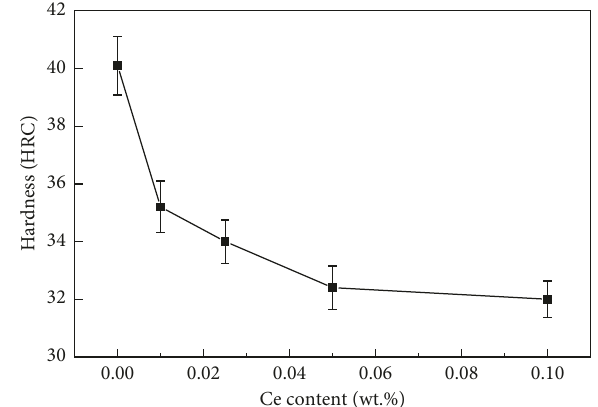
Figure 7: The evolutions of hardness with the rare earth Ce content.